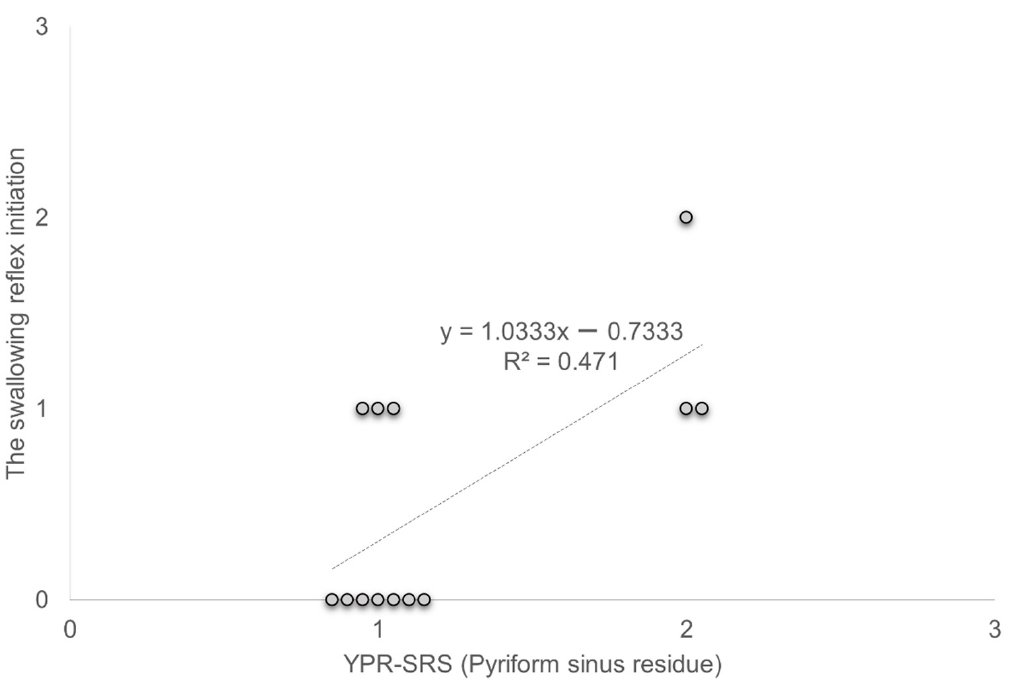
Figure 4. Correlation between YPR-SRS (Pyriform sinus residue) and swallowing reflex initiation. YPR-SRS Yale Pharyngeal Residue Severity Rating Scale.